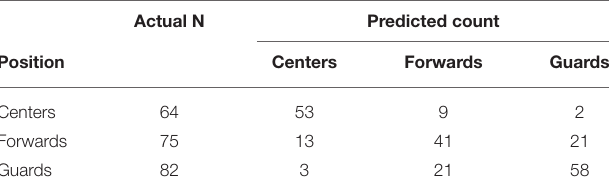
TABLE 2 | A confusion matrix from a multinomial logistic regression on external load variables.